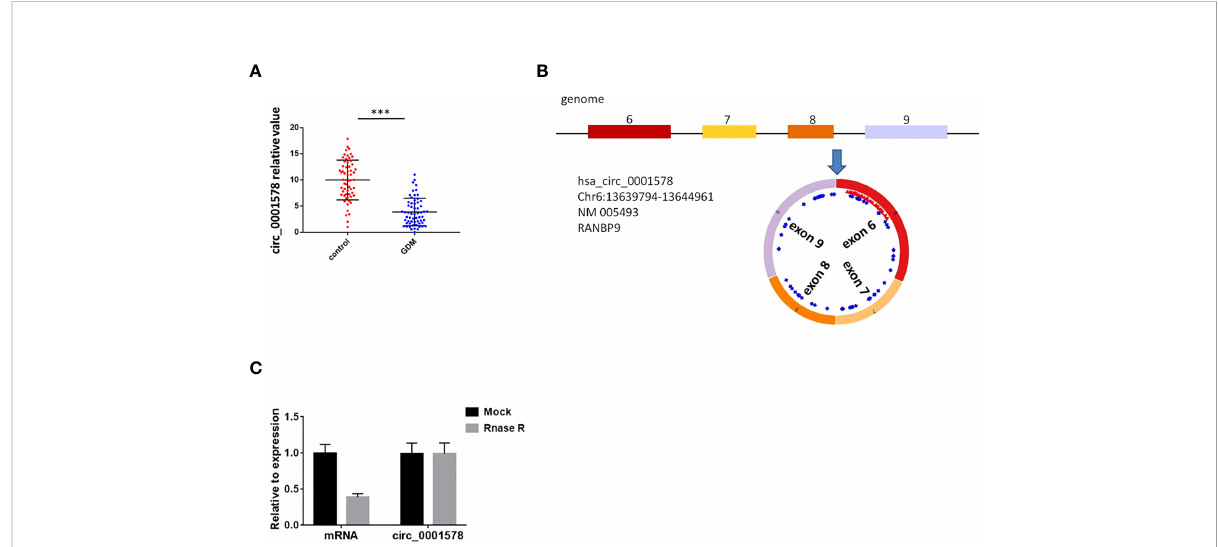
FIGURE 1 CircRNAcirc_0001578 was downregulated in the placental villous tissues of pregnant women with GDM. (A) Relative expression levels of circ_0001578 in the placental villous tissues of pregnant women with or without GMD (3.88 vs.10, P < 0.001). (B) Circ_0001578 originates from splicing exons 6, 7, 8, and 9 of RANBP9. (C) Circ_0001578 was resistant to RNase R digestion, unlike linear RANBP9 mRNA